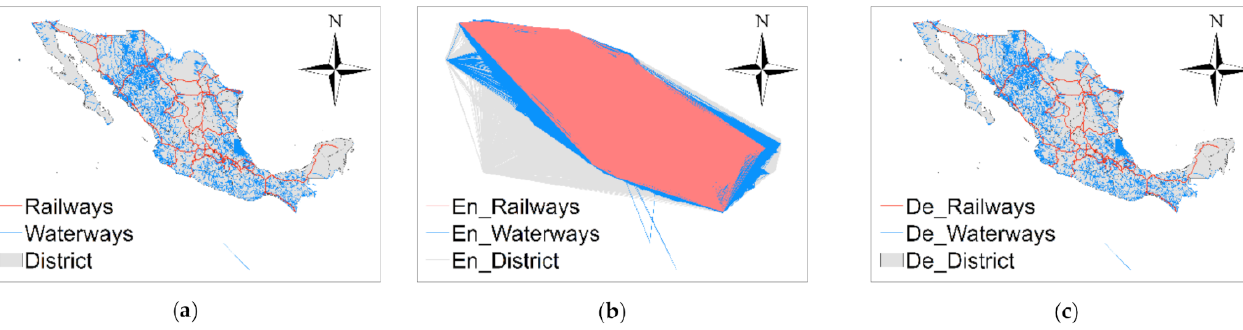
Figure 9. The map with three layers (railways, waterways, and district). ( a ) The original map; ( b ) the cipher map; ( c ) the decrypted